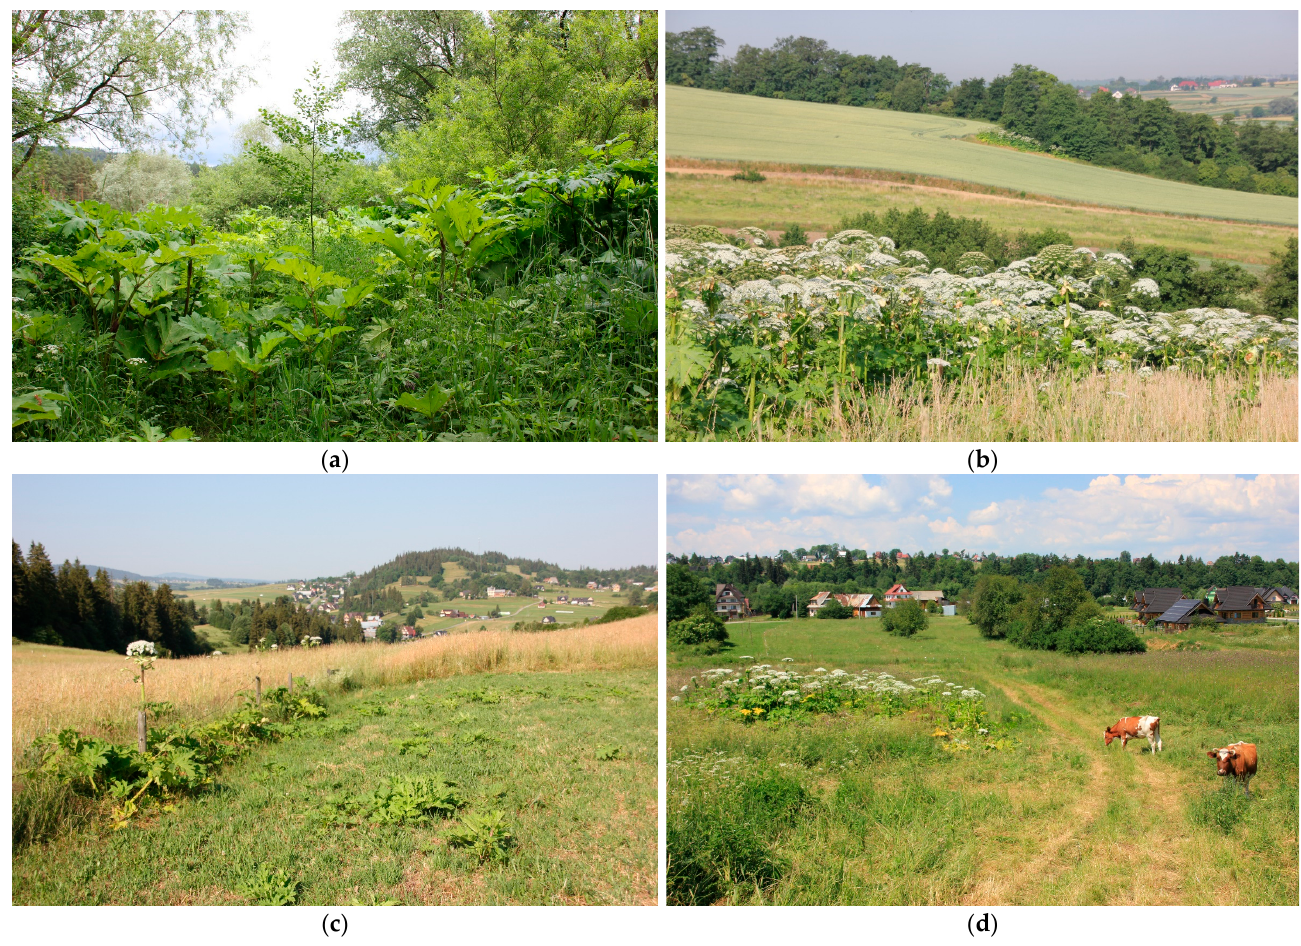
Figure 1. Examples of habitats selected by Caucasian hogweeds (i.e., Heracleum sosnowskyi , Hera- cleum mantegazzianum ): ( a ) riverine willow stand; ( b ) an agricultural landscape with a developed invaded patch in the meadow part in the front of the photo and invaders on the edge of the forest with the ruderal area and cropland in the back; ( c ) an example of hogweeds rebuilding after habitat disturbance (i.e., mowing of the meadow) much faster than native vegetation; ( d ) a patch of Caucasian hogweeds in the meadow with an admixture of ruderal area. Photos by: E. Grz ę dzicka (June–July 2022, South-Eastern Poland).